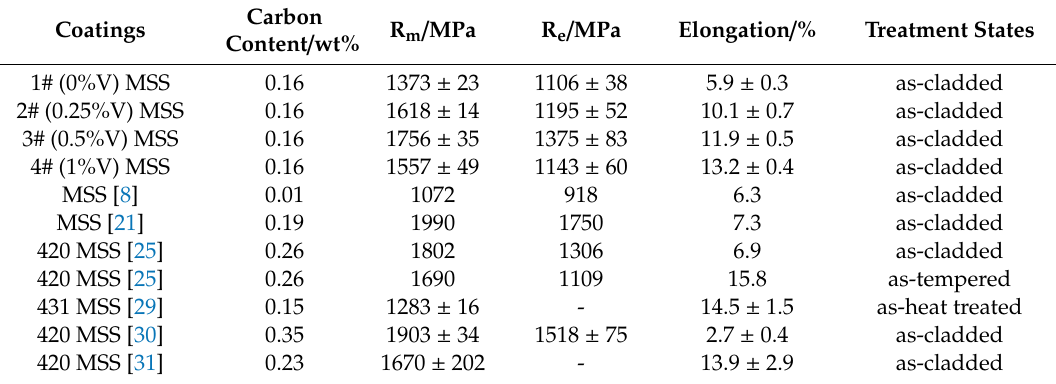
Table 2. Comparison of tensile mechanical properties of di ff erent laser-cladded MSS coatings. Coatings